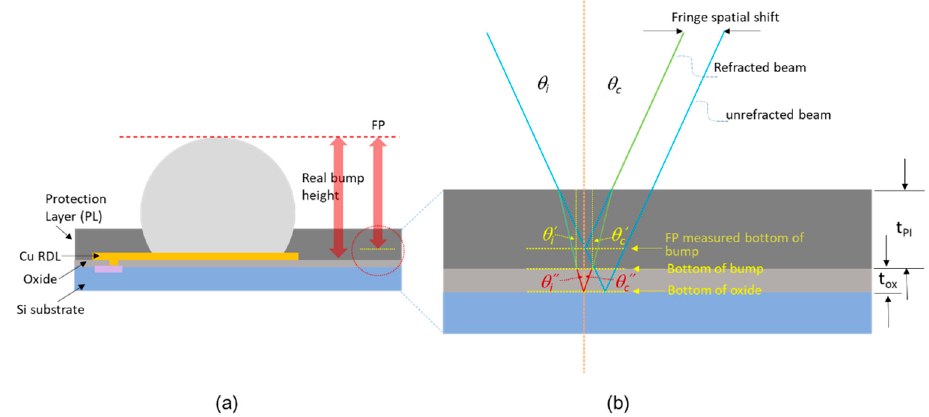
Figure 13. ( a , b ) Modified versions of Figure 5a,b, respectively, with an additional oxide layer between the PI and Si substrate based on the reflectance spectrum. The BGA bump array in the PI sample as shown in Figure 14a was analyzed in detail here. According to Equation (22), θ i = θ c θ c = 19.6 ◦ , d = 250 µ m, m = 1.048 × , and the cos θ c conversion factor d has a constant value of 56.6. The phase modification terms 2 π m sin ( θ i + θ c ) ∆ φ ∆ φ ox in Equations (20) and (21) are given by PL and